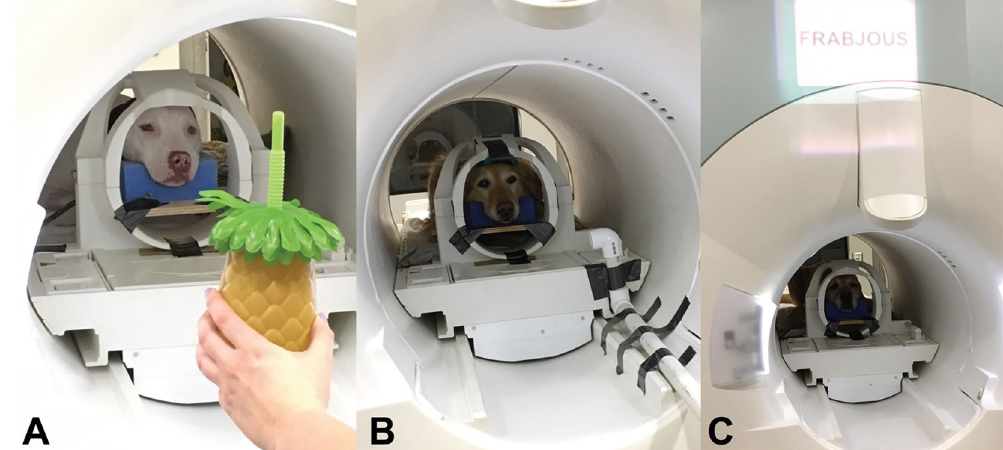
Figure 1. Experimental design with conditioned stimuli. Two novel stimuli were repeatedly presented during three scanning sessions, each devoted to one stimulus modality. One stimulus was associated with food (Reward), one associated with nothing (No Reward). ( A ) Presentation of pineapple object by owner to dog in MRI bore during visual modality session. ( B ) Presentation of odorants to dog in MRI bore via experimenter- controlled olfactometer during olfactory modality session. The owner remained in front of the dog. ( C ) Presentation of pseudoword Frabjous to owner projected above MRI bore opening during verbal modality session. The owner spoke the projected word five times per trial.